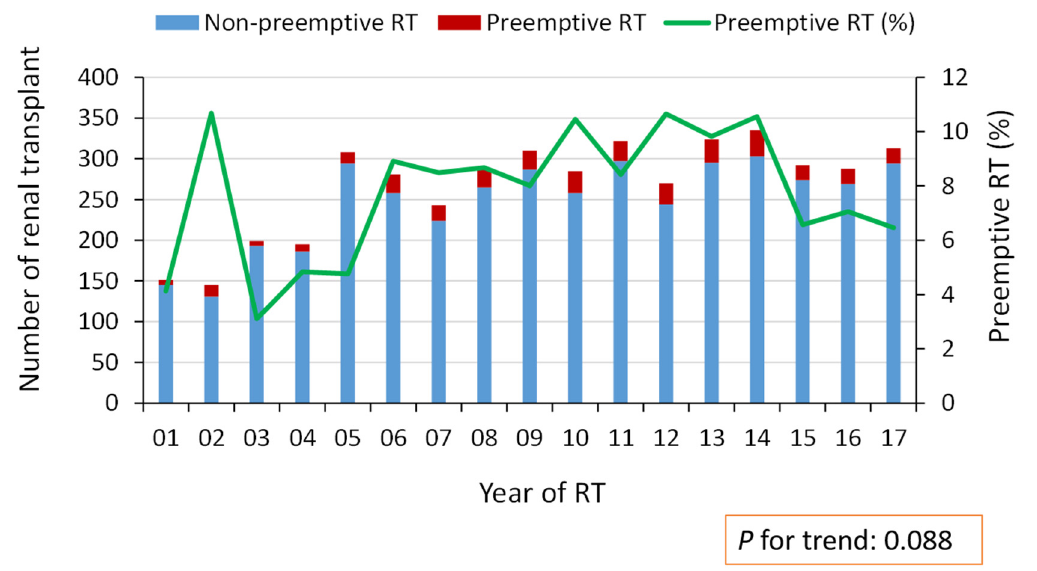
Figure 2. Number of annual preemptive and total renal transplantations in Taiwan from 2001 to 2017. RT: renal trans- plantation .